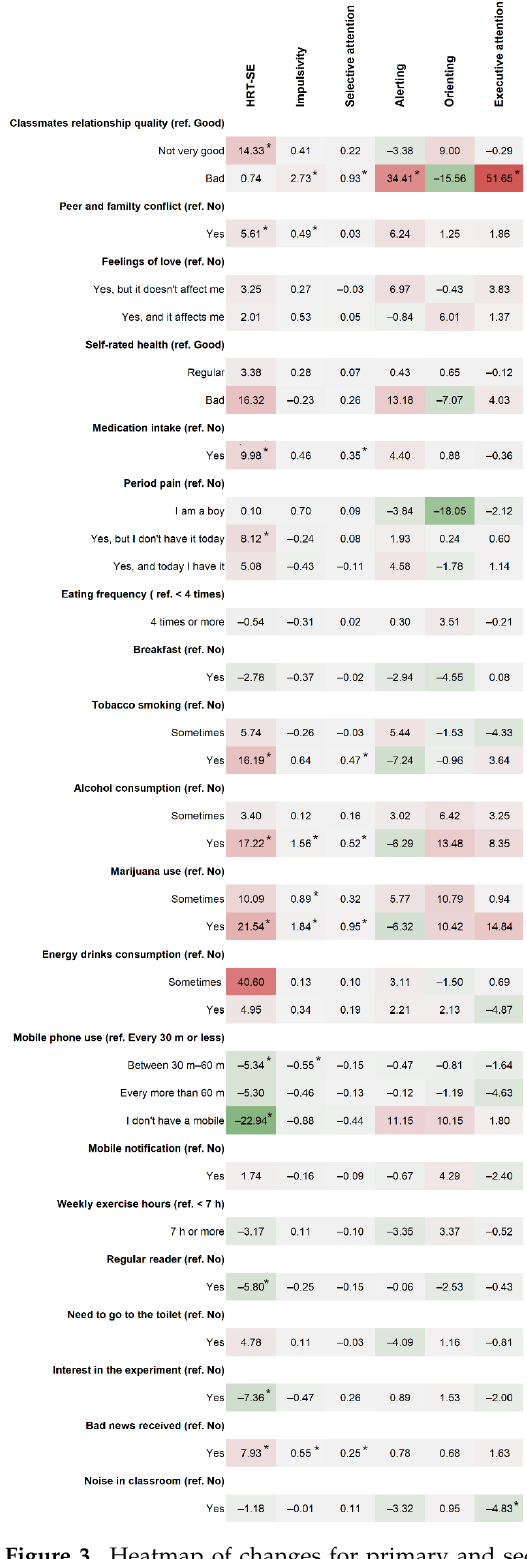
Figure 3. Heatmap of changes for primary and secondary attention outcomes. Supplementary Tables S3 and S7 provide the specific 95% confidence interval and p -values. Lower change HRT- SE (percent) impulsivity (count), selective attention (count), alerting score (ms), orienting score (ms) and executive attention score (ms) indicate better attention performance. Significant changes ( p -value < 0.05) are indicated with a